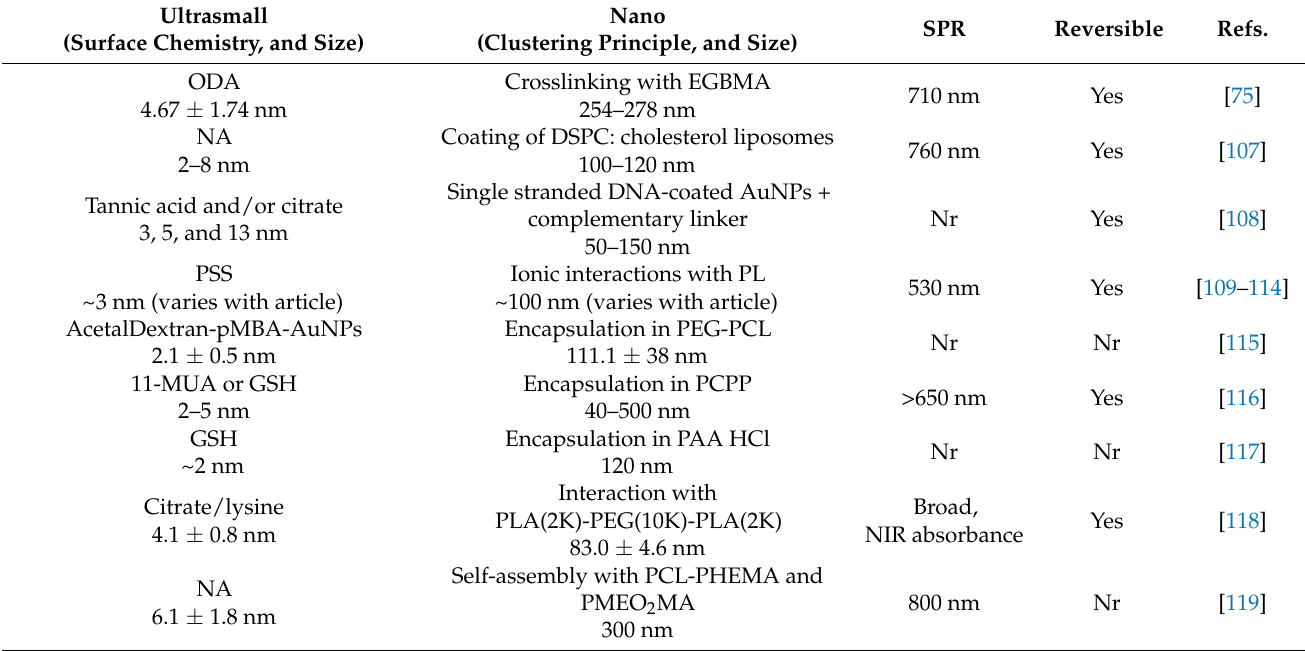
Figure 4. Generalized principle of the ultrasmall-in-nano approach. Table 3. Methods of generating ultrasmall-in-nano constructs.